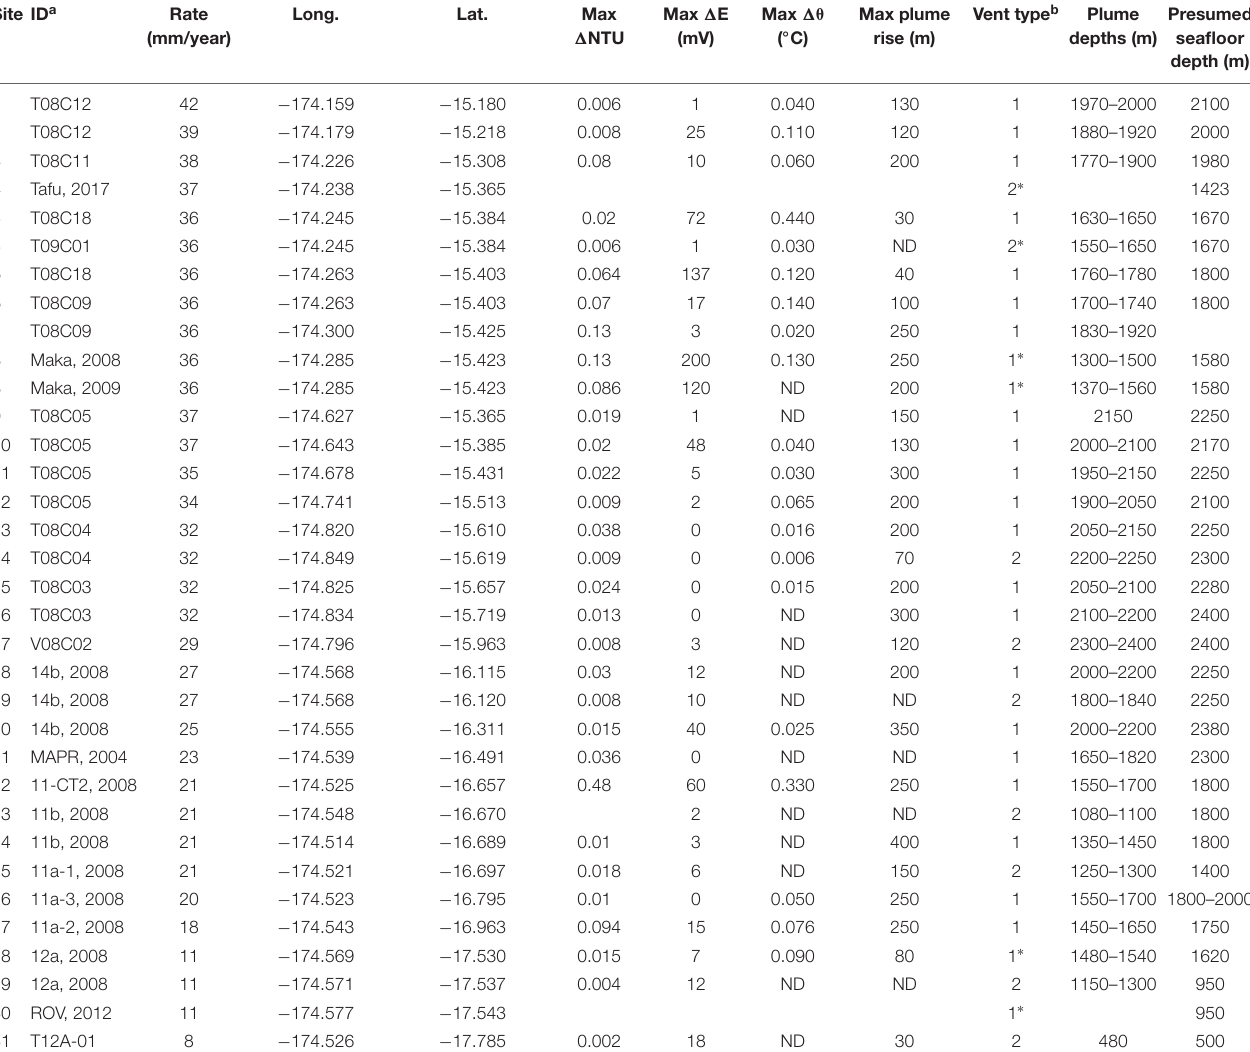
TABLE 1 | Characteristics of plumes from NE Lau Basin spreading